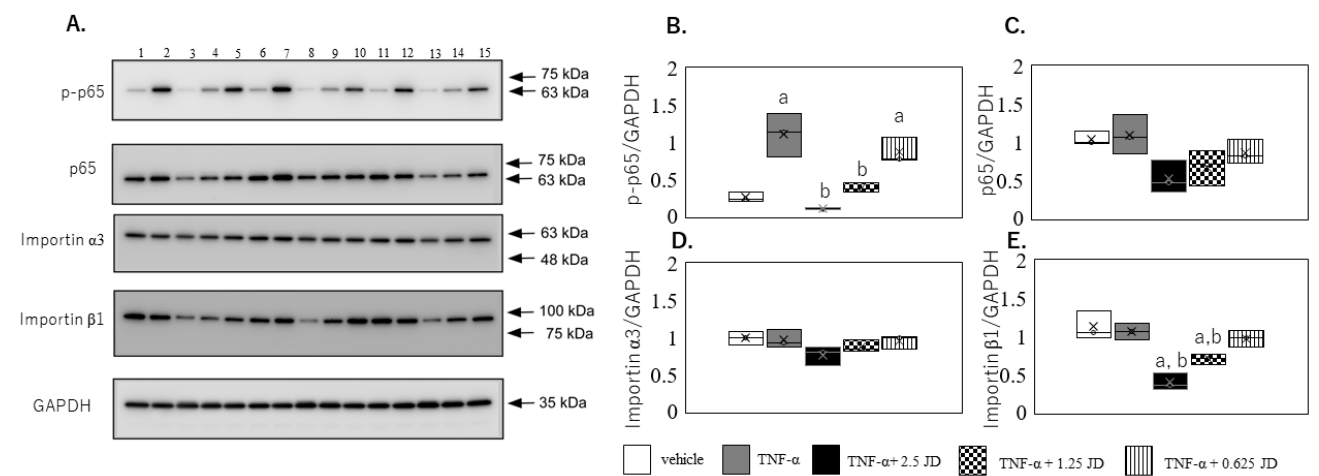
Figure 4. Effect of jietacin derivative on the NF- κB pathway in SW982. Western blotting for p65, phosphorylated p65 (p-p65), importin α3, importin β1 and GAPDH ( A ). Densitometry of western blot protein bands for p-p65 ( B ), p65 ( C ), importin α3 ( D ), and importin β1 ( E ) were normalized to the expression of GAPDH ( n = 3). Vehicle, Lane 1,6,11; TNF- α , Lane 2,7,12; TNF- α + 2.5 JD, Lane 3,8,13; TNF- α + 1.25 JD, Lane 4,9,14; TNF- α + 0.625 JD, Lane 5,10,15. a p < 0.05 in comparison with vehicle, b p < 0.05 compared to TNF- α.